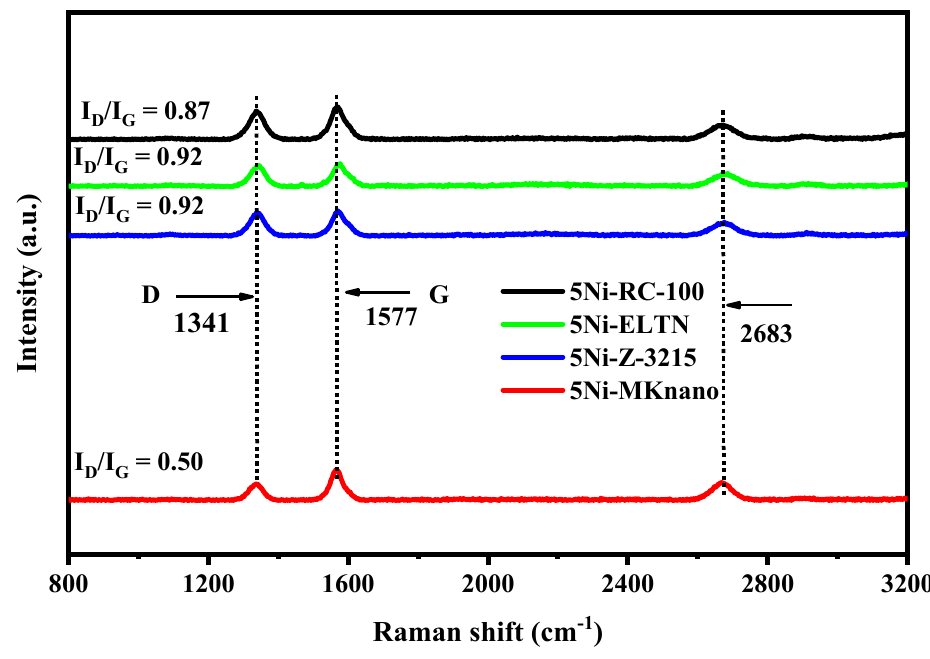
Figure 8. Raman spectra of used different sources of zirconia-supported Ni catalysts operated at 700 °C for 7 h.